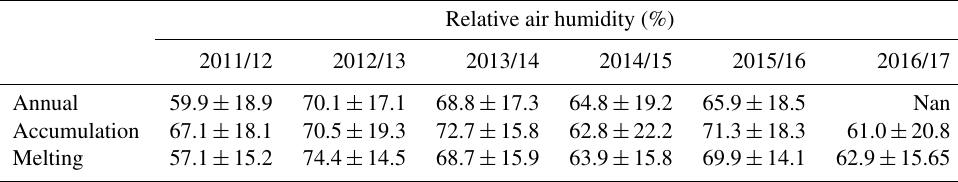
Table 2. Mean and standard deviation of relative humidity for the five snow seasons for the annual, accumulation and melt